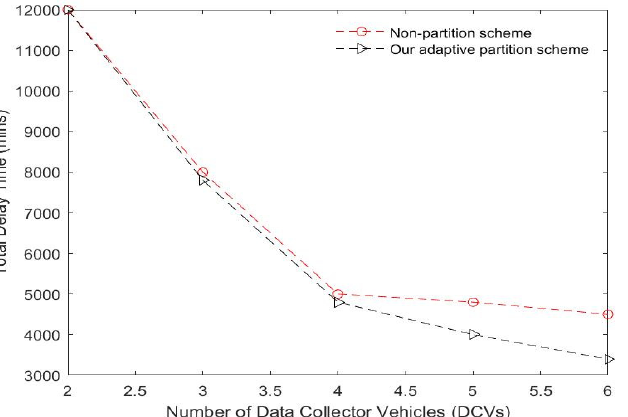
Figure 9. Comparing adaptive and non-adaptive partition schemes in terms of number of data col- lector vehicles (DCVs).